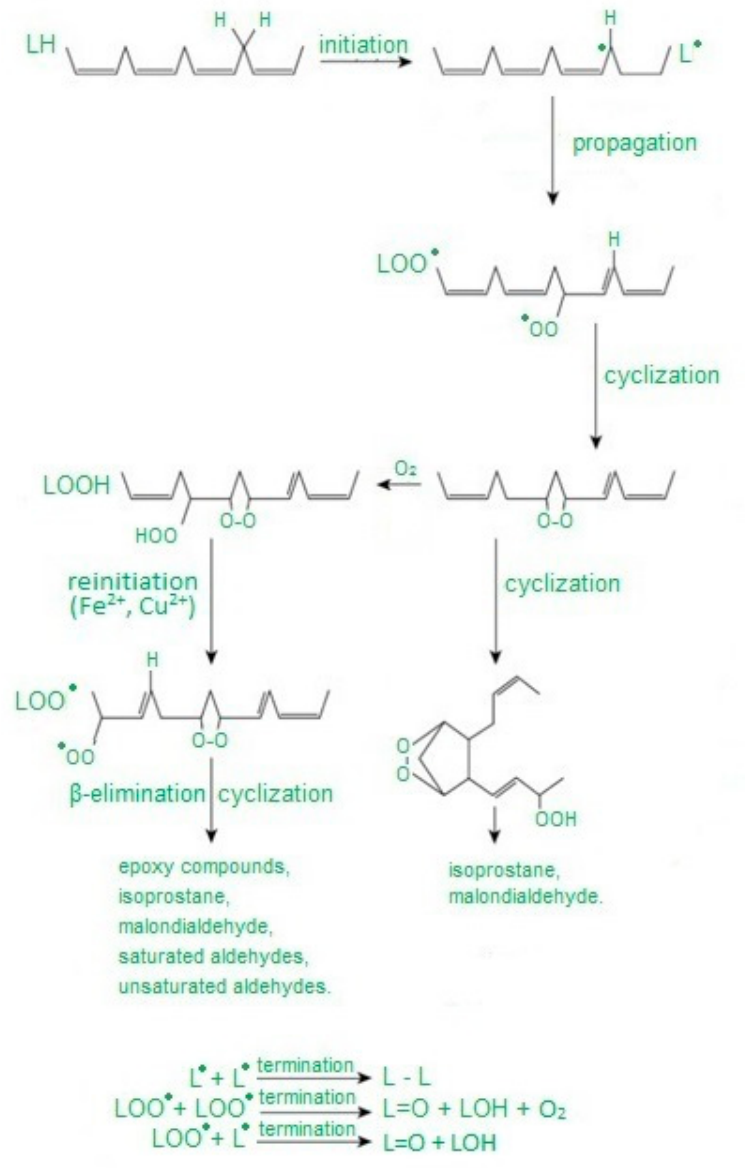
Figure 1. Abbreviation: L—carbon-centered lipid radical, LO—lipid alkoxyl radical, LOO—lipid peroxy radical, LOOH—lipid hydroperoxide. Free radical peroxidation of lipids according to [36] as modified by the authors.